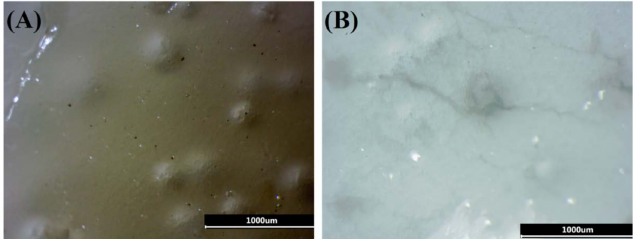
Figure 5. Photos of the surfaces of the crosslinked polymer before swelling in water ( A ) and after reaching the equilibrium degree of swelling in water ( B